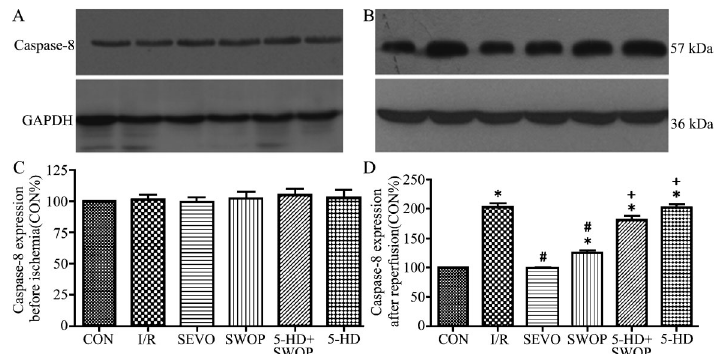
Figure 4. Caspase-8 protein expression before ischemia ( A , C ) and 2 h after reperfusion ( B , D ). CON: control; I/R: ischemia/reperfusion; SEVO: sevoflurane; SWOP: second window of protec- tion; 5-HD: 5-hydroxydecanoate. *P , 0.05 vs CON; # P , 0.05 vs I/R group; + P , 0.05 vs SWOP group (one-way